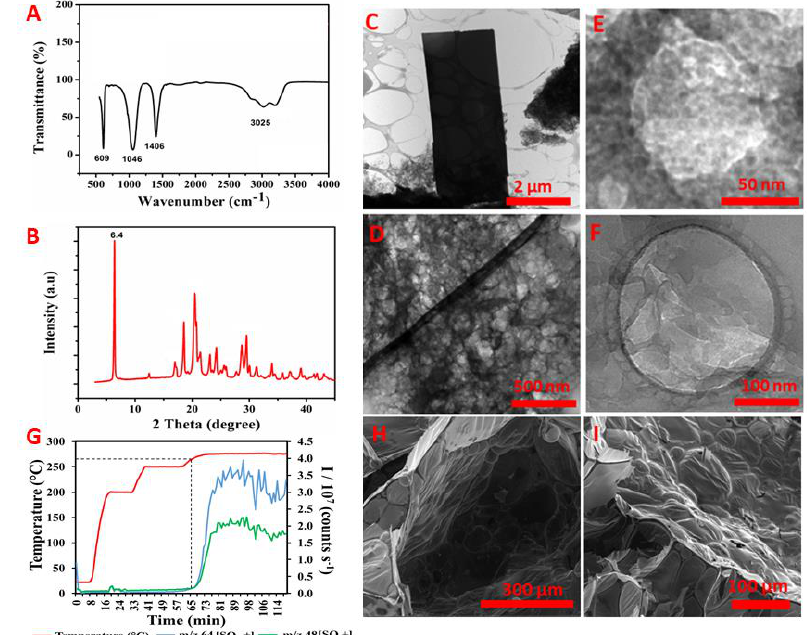
Figure 1. FTIR spectrum of ( A ) sulfonated aniline oligomers (SAOs), ( B ) XRD diffraction peaks of SAO. TEM images of: ( C ) SAO macroflake, ( D ) bunch of spherulites of the surface of macrosheets, ( E ) isolated single spherulites and ( F ) expansion of a spherulites. ( G ) The temperature-dependant mass spectrum of SAO in the temperature range of 30–275 °C, ( H , I ) “bubble wrap” type macroporous P-SAO.